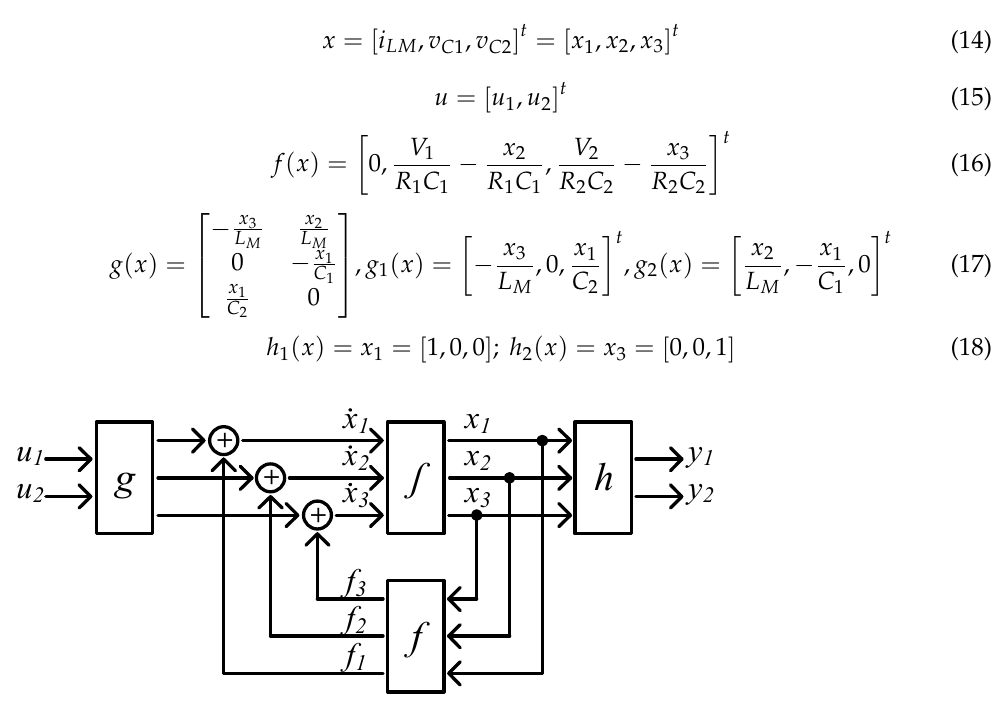
Figure 7. Block diagram representation of the DIDO system.